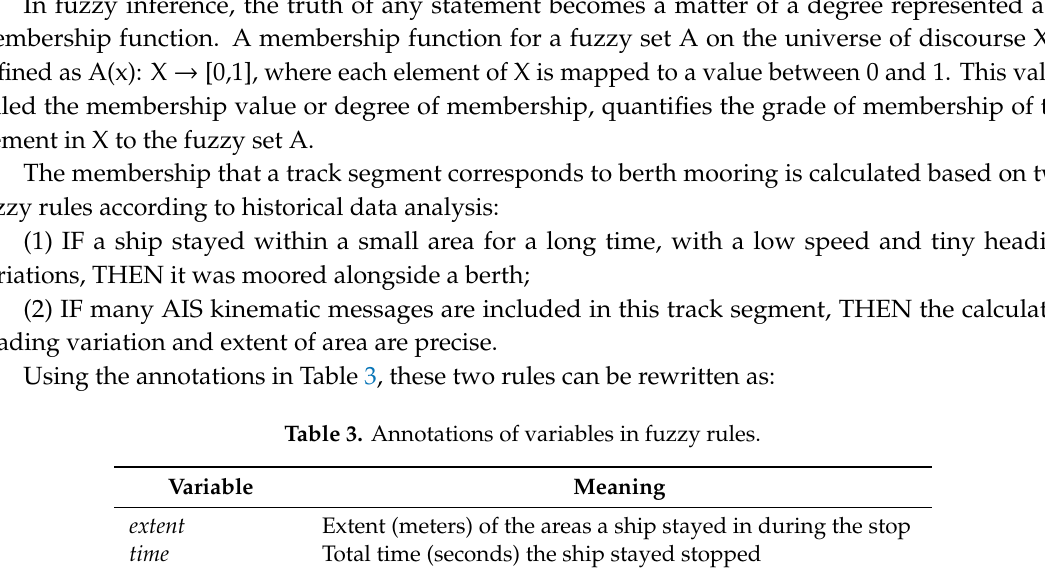
Table 3. Annotations of variables in fuzzy rules.